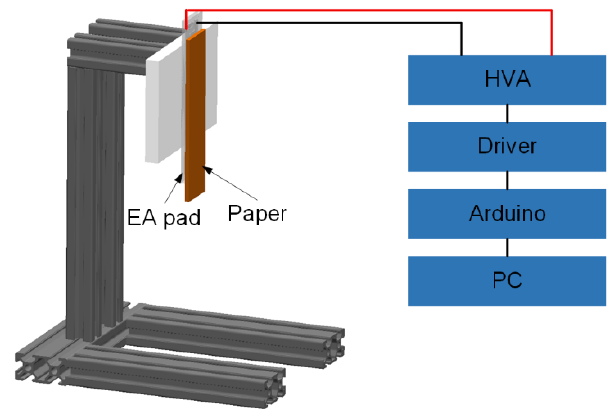
Figure 3. Schematic diagram of the tangential force measurement device.